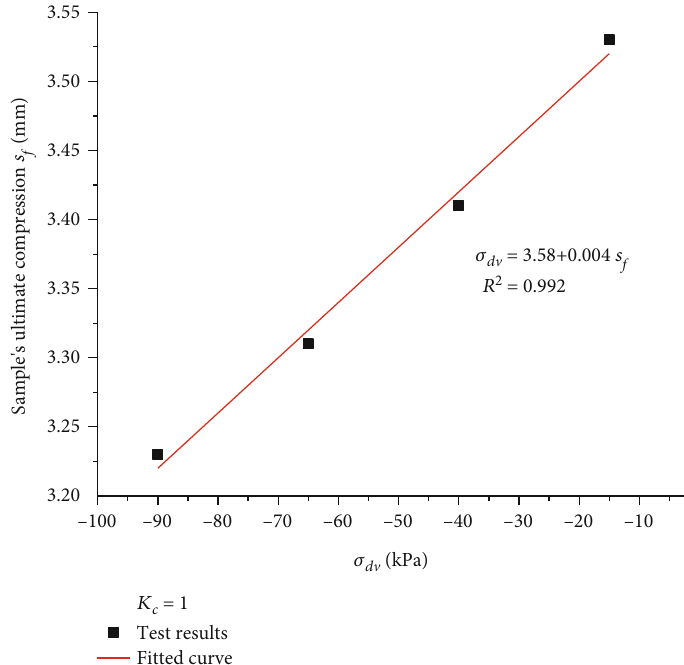
Figure 17: The relation curve between overconsolidation clay ultimate compression and stress di ff erence.